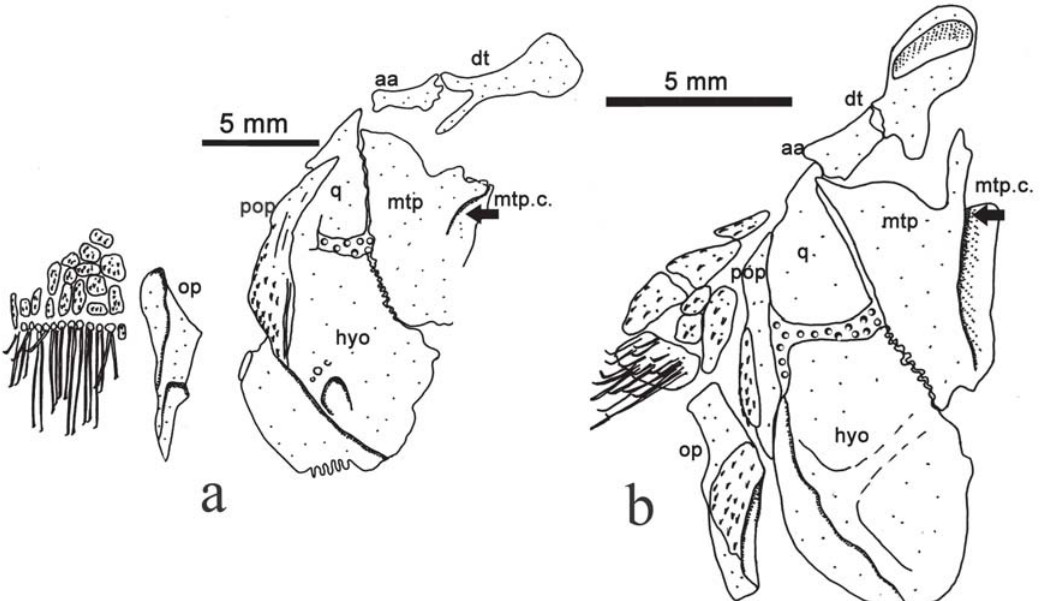
Fig. 4. Suspensorium, dorsal view. a. Parancistrus aurantiacus ; b . Parancistrus nudiventris . aa = angulo-articular, dt = dentary, hyo = hyomandibular, mpt = metapterygoid, mpt.c.= metapterygoid channel, op = opercle; pop = preopercle, q = quadrate.